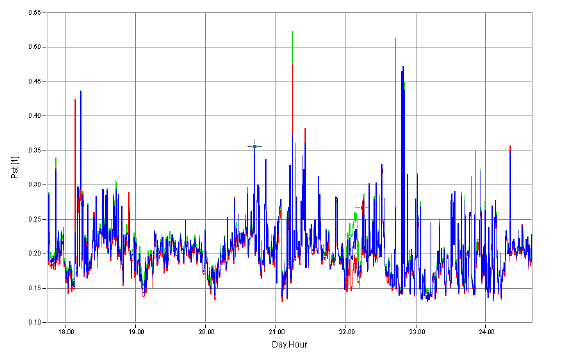
Fig. 1. Short-term flicker waveform P St .